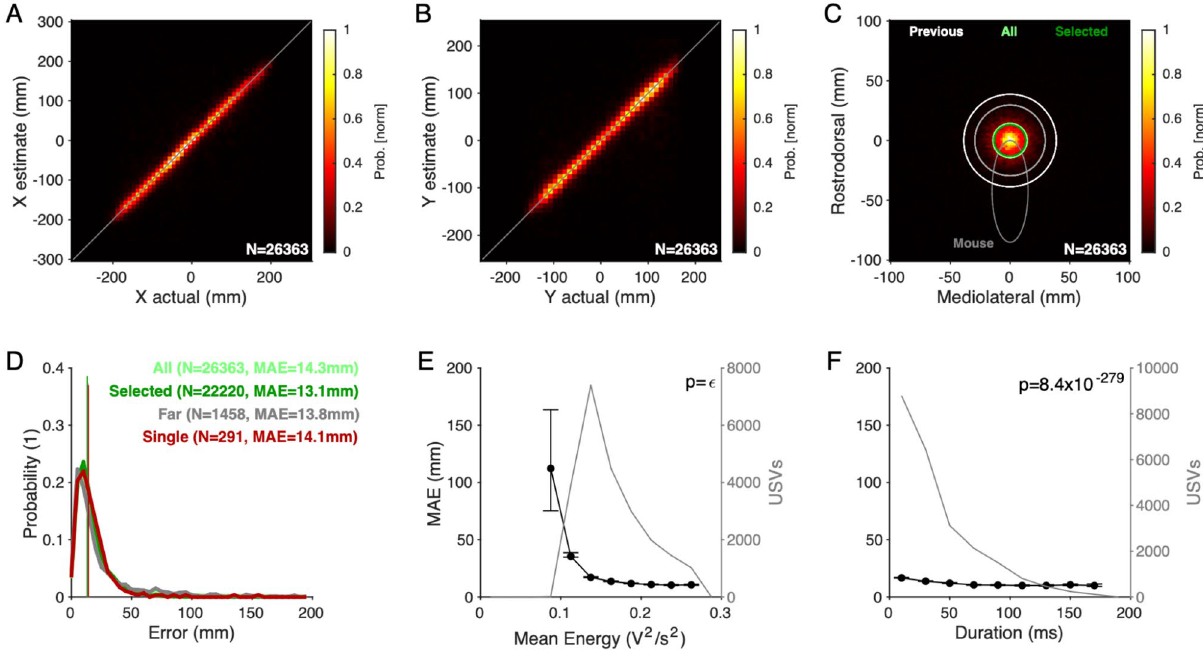
Figure 3. SLIM improves spatial accuracy in localizing vocalizations substantially over previous methods. ( A ) Density of actual (male) snout locations along the X dimension (horizontal in the video image) concentrated closely around the diagonal. Colors indicate peak-normalized occurrence rates. See Fig. 3 SF1 for accuracies obtained using a 3 microphone setup. ( B ) Same as A for the Y coordinate, again closely concentrated around the diagonal. ( C ) Combined 2D localization of USVs centered on the mouse snout. The average accuracy is visualized by a circle whose radius is the median average error (MAE; light green: all USVs; dark green: selected—i.e. reliably assignable—USVs see Methods ; white: from Neunuebel et al . 16 and gray from Warren et al . 25 (Jackknife4) for reference). ( D ) The distribution of localization errors for the entire set of vocalizations has an MAE of 14.3 mm (light green), while the reliably assignable ones (’selected’) had an improved MAE of 13.1 mm (dark green). When considering only USVs at times when the mice were > 100 mm apart, the MAE was 13.8 mm, very similar to the error obtained for localizations of a single male vocalizer at an MAE = 14.1 mm. The error density is displayed as a normalized histogram. ( E ) Location accuracy significantly improved with the average acoustic energy of the vocalization (black). The detected vocalizations had a mean energy starting at 0.1 V 2 /s 2 and ranging up to 0.3 V 2 /s 2 (gray). Error bars show 2 SEMs above and below, based on the percentiles corresponding to 1 SD for a normal distribution ([18,82]%) divided by √ n , where n is the number of USVs in the bin of Mean Energy. The p-value was within the computer precision epsilon. ( F ) The MAE (black) showed a significant dependence on the duration of USVs, improving with longer durations, which are, however, more rare in comparison to short vocalizations